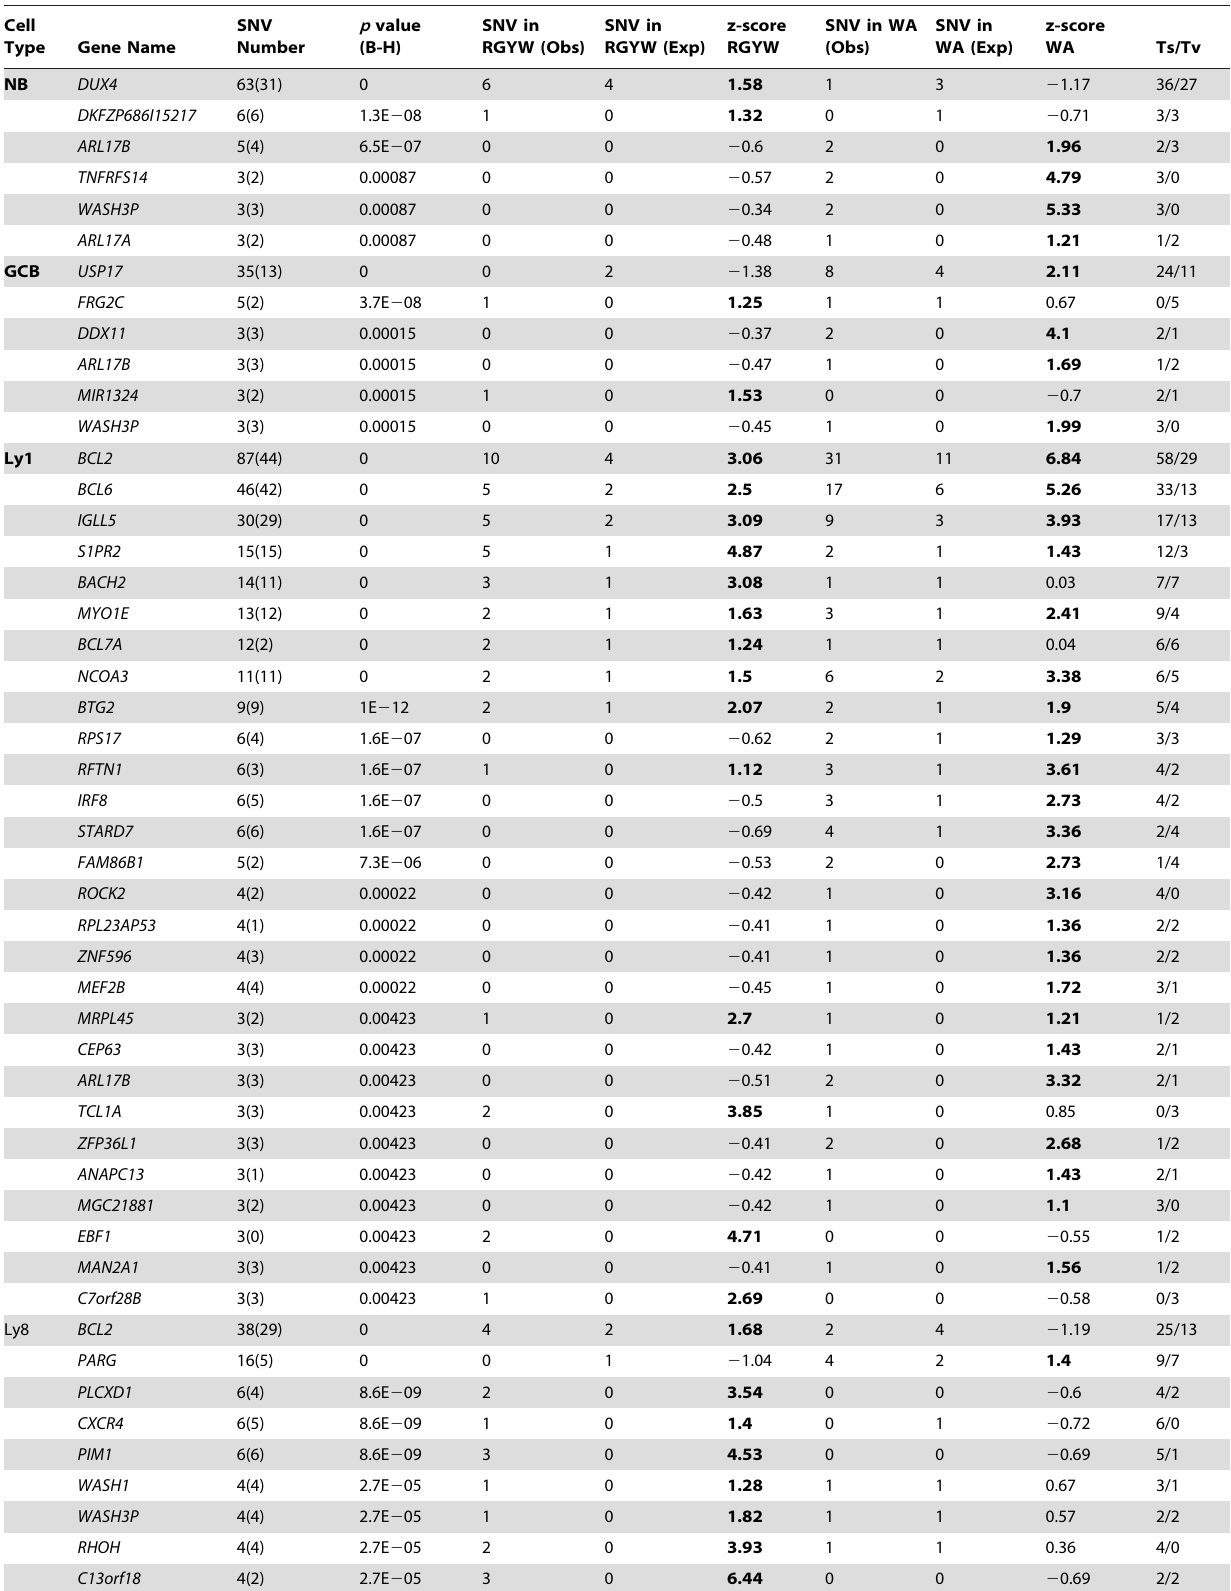
Table 2. SHM hotspot genes in NB, GCB, OCI-Ly1, and OCI-Ly8 cells.